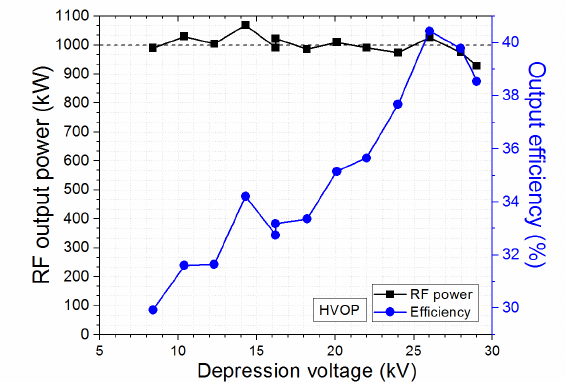
Fig. 3. RF power and corresponding total output efficiency (in depressed collector operation) with respect to the depression voltage for the HVOP (V acc  86 kV and beam current I b  43